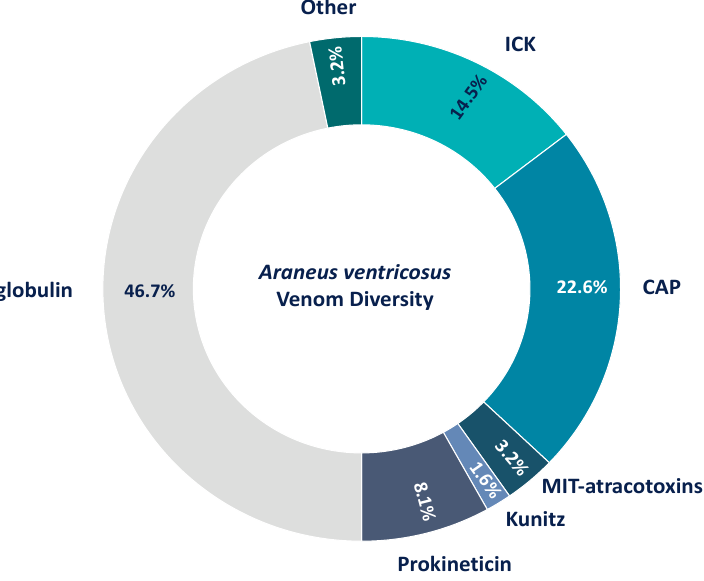
Figure 5. The venom protein profile of Araneus ventricosus derived from the reanalysis of the original study [36]. Given are identified proteins that could be annotated via Interproscan in percentages of the total diversity. From the 62 proteins within the dataset, most were assigned as thyroglobulins and, similar to A. bruennichi , CAPs.